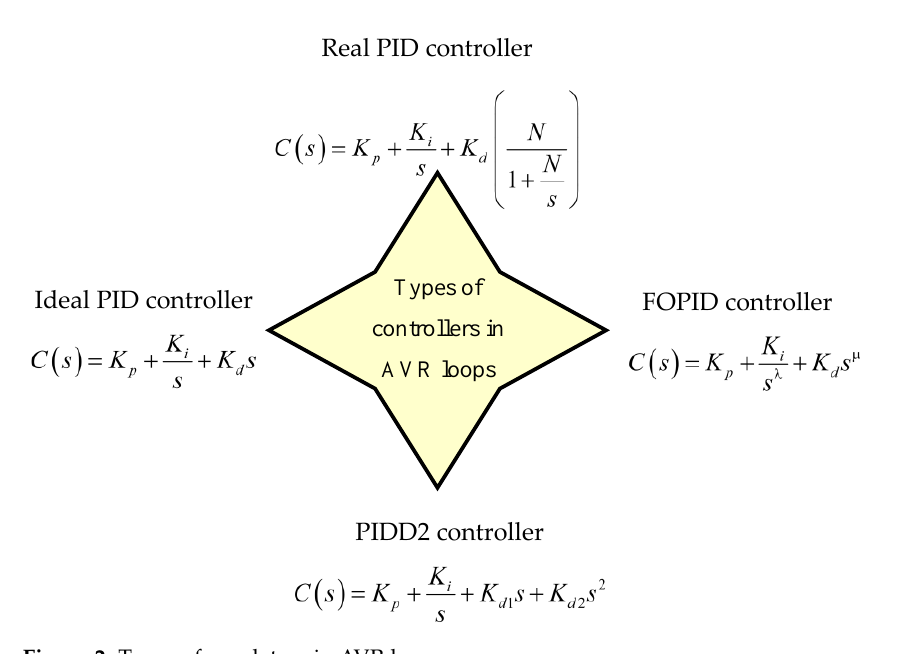
Figure 2. Types of regulators in AVR loops.